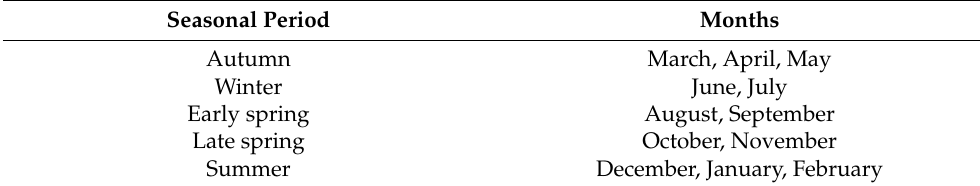
Table 2. Seasonal periods used in the forage value